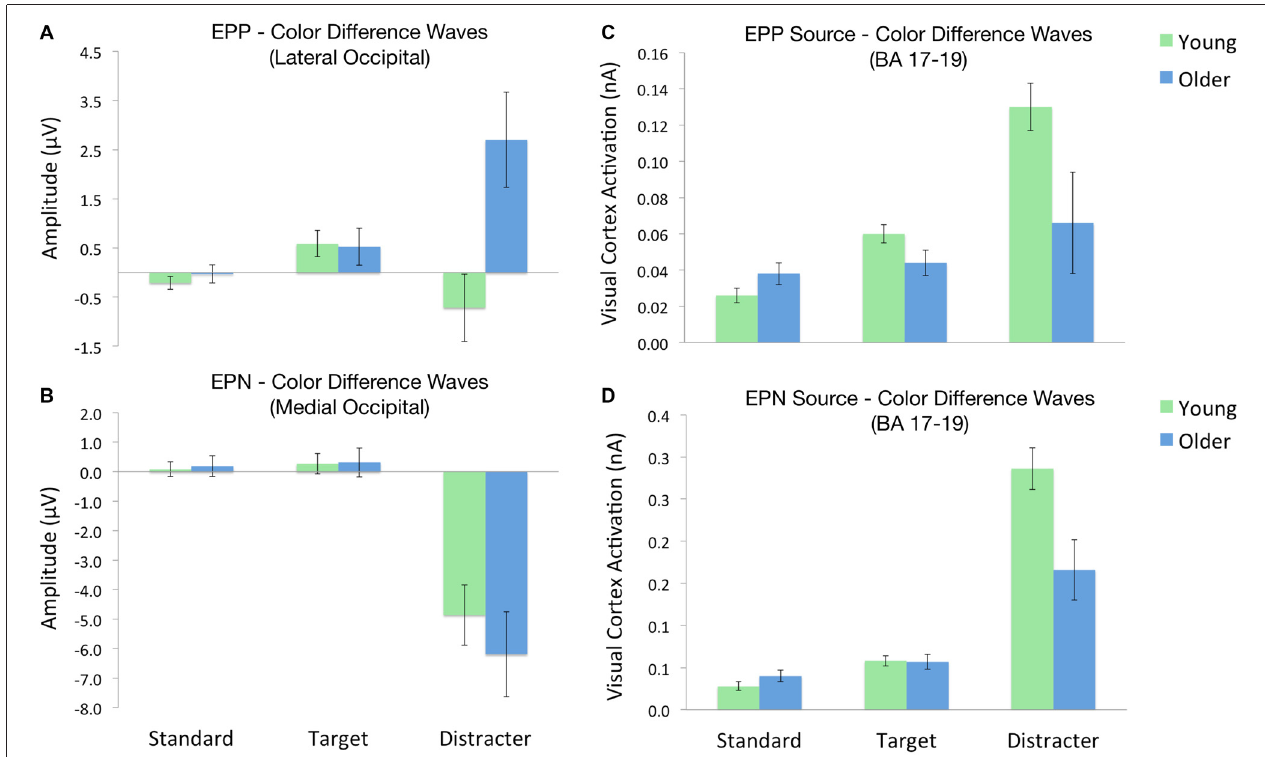
FIGURE 3 | ERP amplitudes and source activations across each oddball stimulus. Each value depicts the contrast between stimuli in the color and gray distracter blocks (i.e., color-gray difference waves). (A) EPP amplitudes across lateral occipital electrodes. (B) EPN amplitudes across medial occipital electrodes. (C) Visual cortex source activity during the EPP time window. (D) Visual cortex source activity during the EPN time